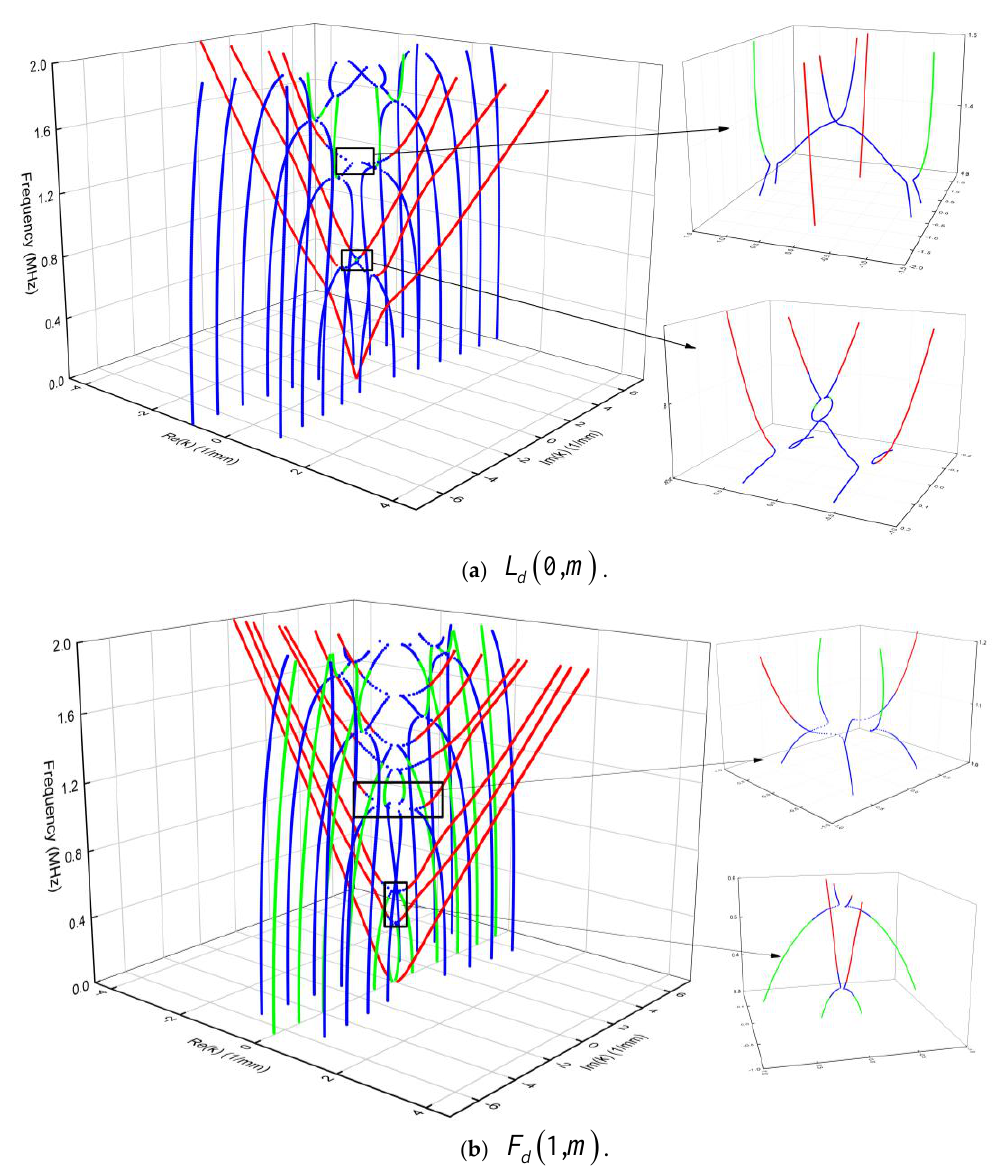
− ω curve for the damped waveguide: ( a ) L